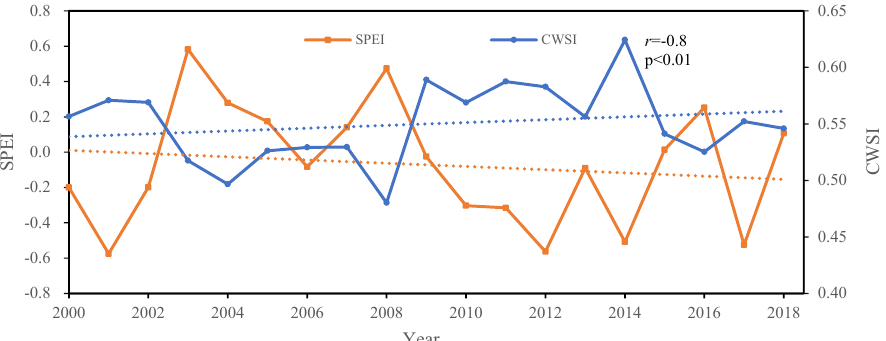
Figure 2. Temporal changes in the SPEI (3-month scale) and CWSI in the North China Plain from 2000 to 2018 ( r represents the correlation between SPEI and CWSI, and p is used to evaluate the significance of the correlation described above).